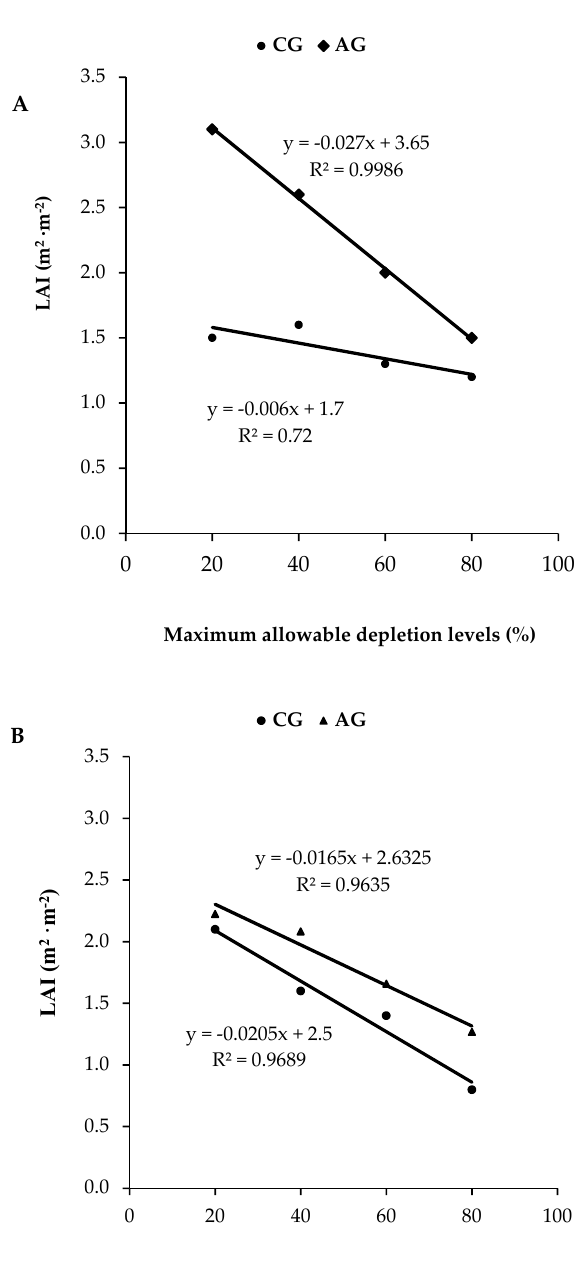
Figure 4. Peak Leaf Area Index (LAI) values of two ginger species in response to different water regimes during the ( A ) 2015/2016 and ( B ) 2016/2017 cropping seasons. CG: Commercial ginger; AG: African ginger; Lsd = 0.93 and 0.53 for Figure A and B respectively.